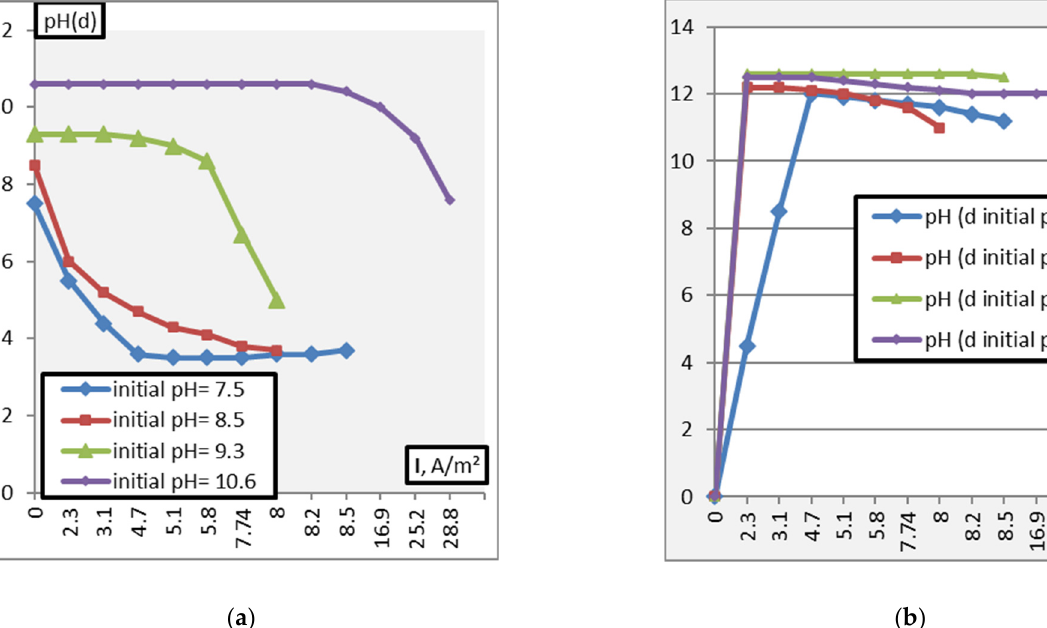
Figure 7. Dependence of the pH. ( a )—pH(d), ( b )—pH(c)) adjustment of alkaline solutions on the current density (d— dialysate,